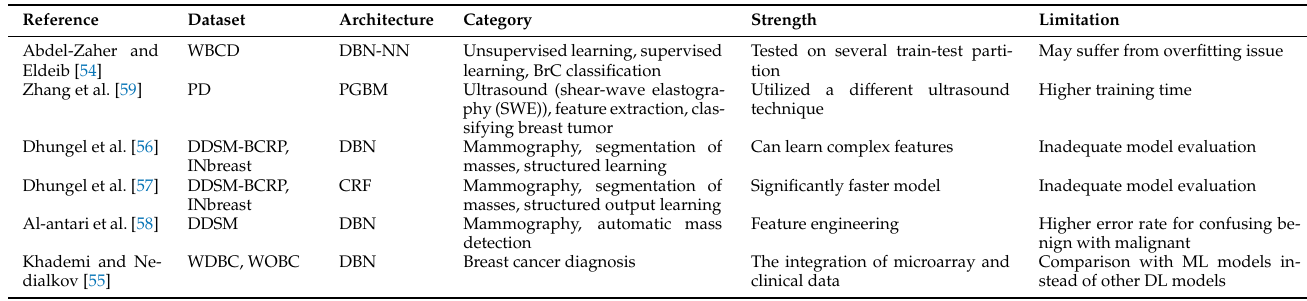
Table 4. State-of-the-art studies based on DBN architecture.